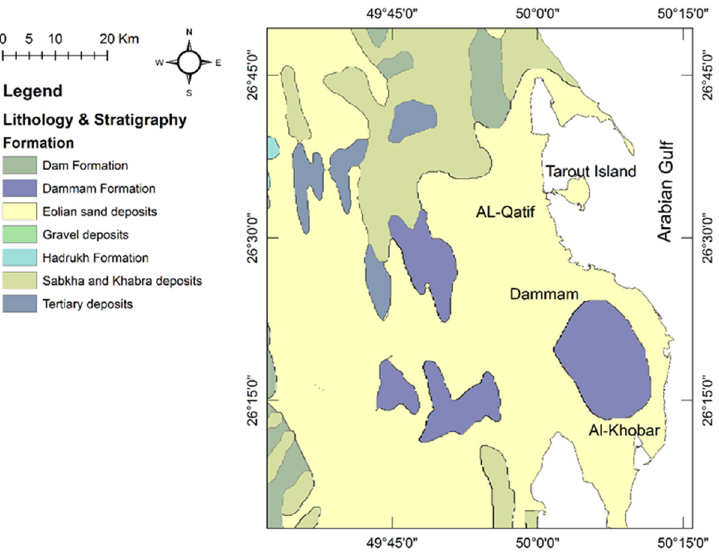
Figure 4. Surface geology map of the study area [29].